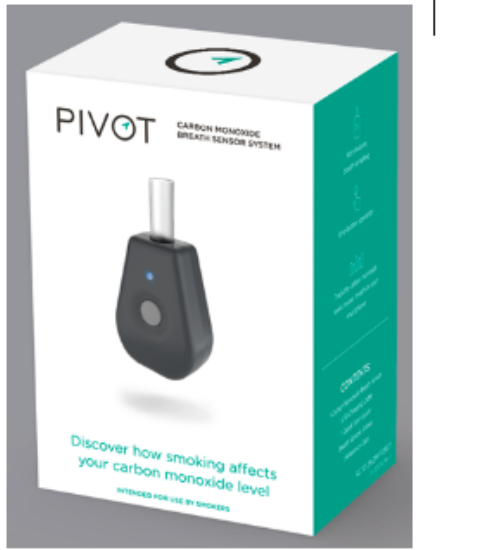
Figure 2. The Pivot carbon monoxide (CO) breath sensor.